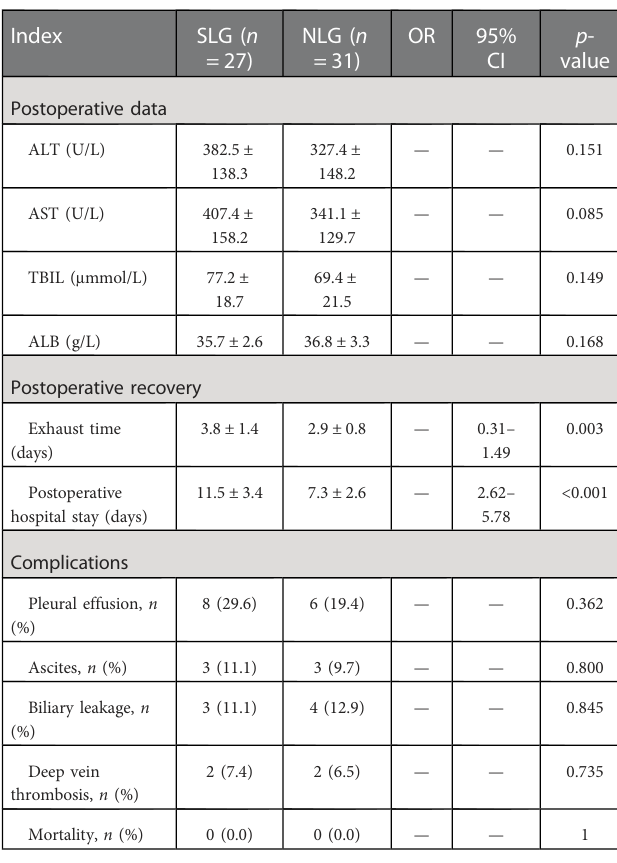
TABLE 3 Postoperative outcomes and complications of patients between the two